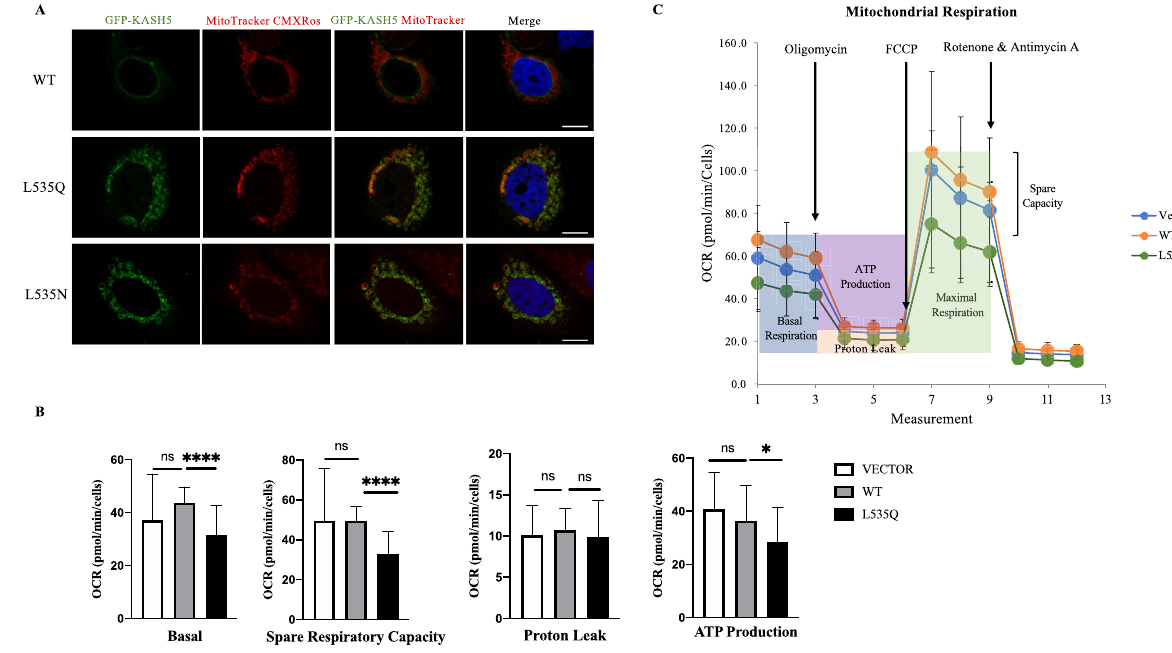
Figure 5. L535Q KASH5 reduces mitochondrial function, but does not impair membrane potential. ( A ) Colocalization between Mitotracker Red CMXROS and L535Q or L535N KASH5. Scale bar 10 μm. ( B ) Mitochondrial function assessed by measuring the oxygen consumption rate (OCR) in mitochondria from U2OS cells transfected with an empty vector, wild-type or L535Q KASH5. Black arrows indicate the time of addition of each mitochondrial functional modifier: Oligomycin, FCCP, Rotenone & Antimycin A. Data are expressed as mean ± standard error. ( C ) Basal respiration, Spare respiration capacity, proton leak and adenosine triphosphate (ATP) production and spare respiratory capacity of the cells. Error bars represent standard error. P < 0.05. The results are the average of two biological replicates and 30 technical replicates for each